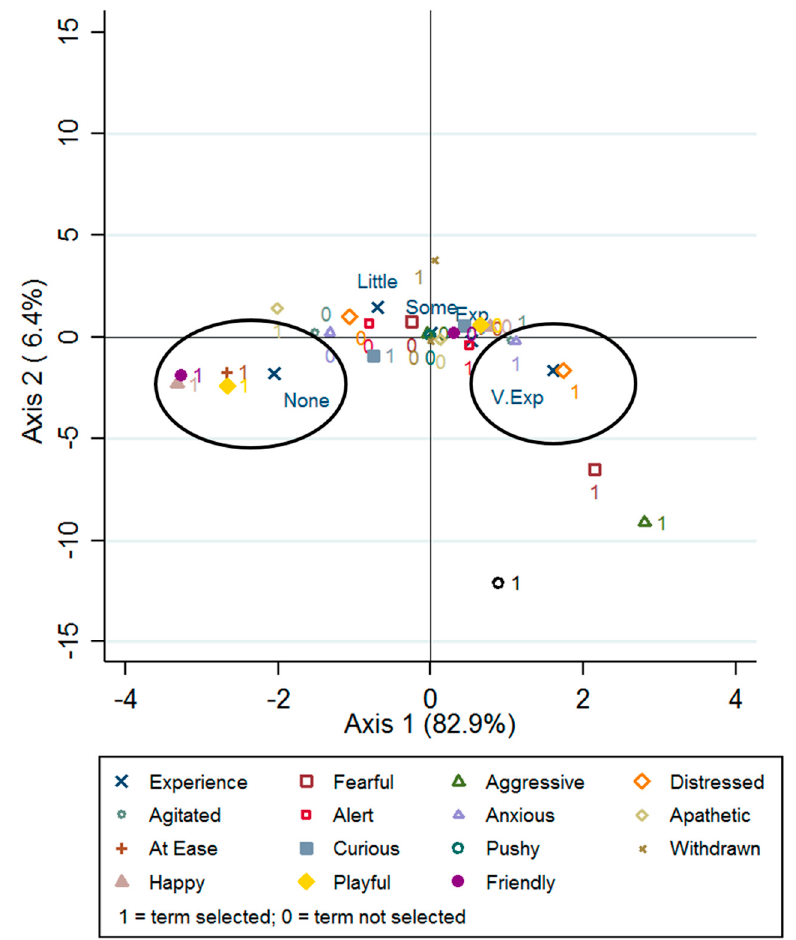
Figure 1. Multiple correspondence analysis showing the terms selected by first-year veterinary science or veterinary technology and undergraduate equine science students to describe the horse’s behaviour shown in Video 3, and the level of the students’ experience with horses. 1 = term selected at any strength; 0 = term not selected. ‘Experience = None—never interacted with a horse prior to the start of this paper’, ‘Little—interacted with or ridden horses a few times under supervision’, ‘Some—interacted with or ridden horses regularly under supervision’, ‘Experienced—interacted with or ridden horses regularly unsupervised’ or ‘Very Experienced—competitive rider or worked in the horse industry’. Black circles are used to indicate clusters in the data.